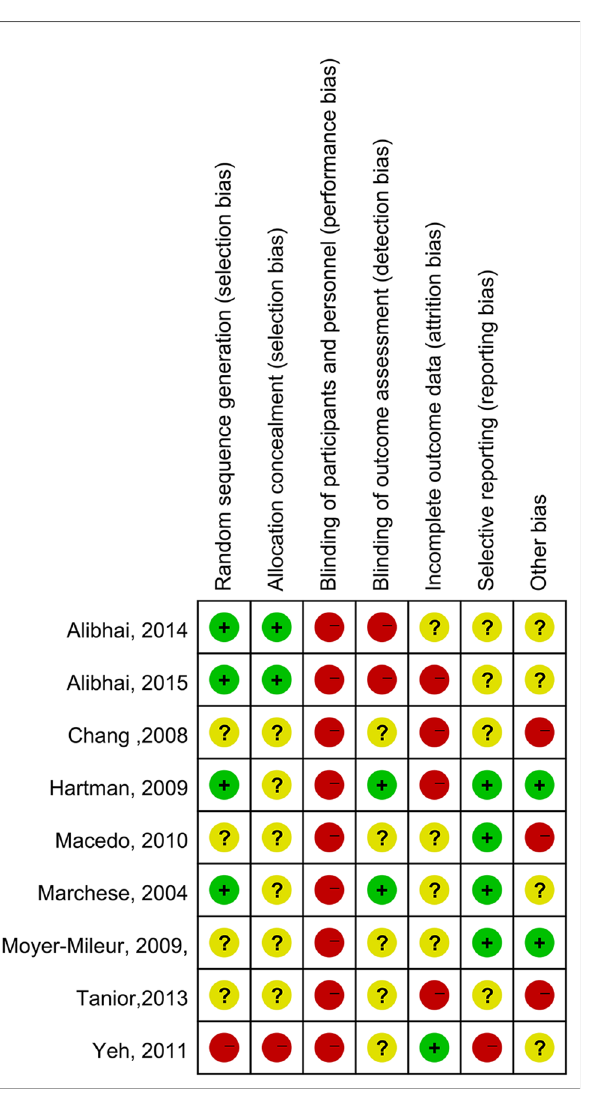
Fig 3. Risk of bias